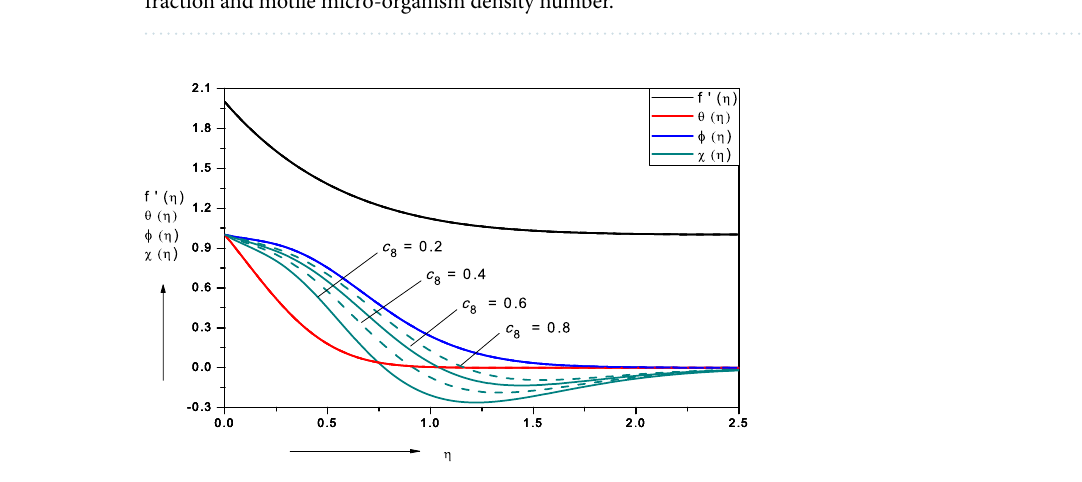
fraction and motile micro-organism density number.